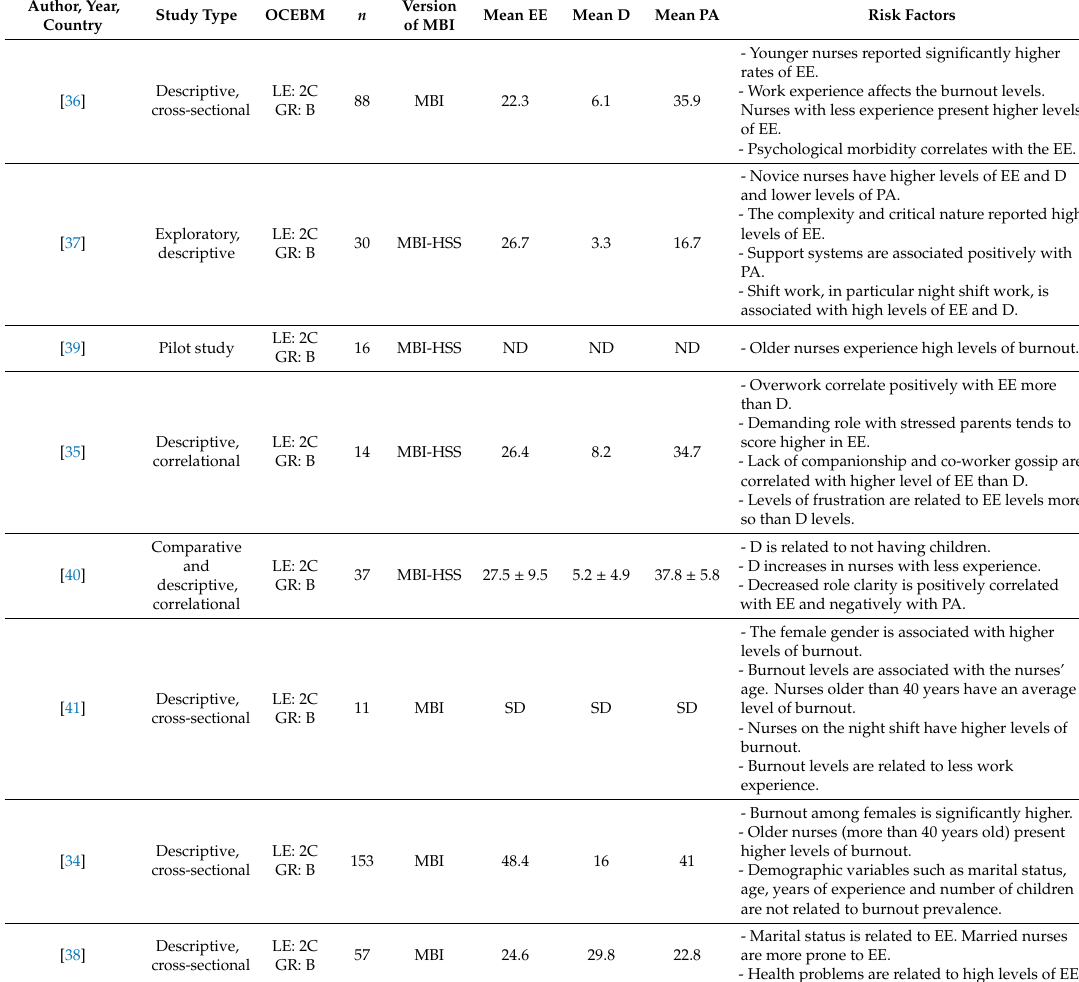
Table 3. Characteristics of included studies ( n =